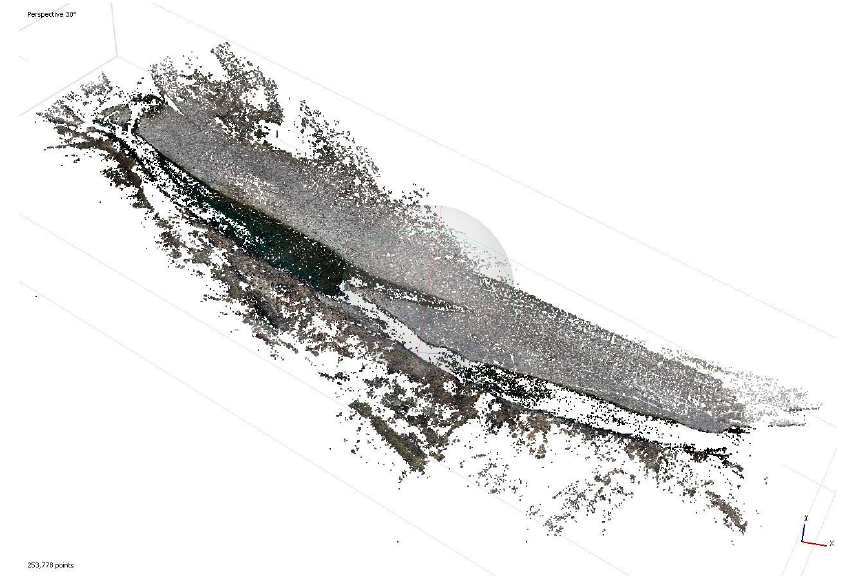
Figure 3. Scattered point cloud example.